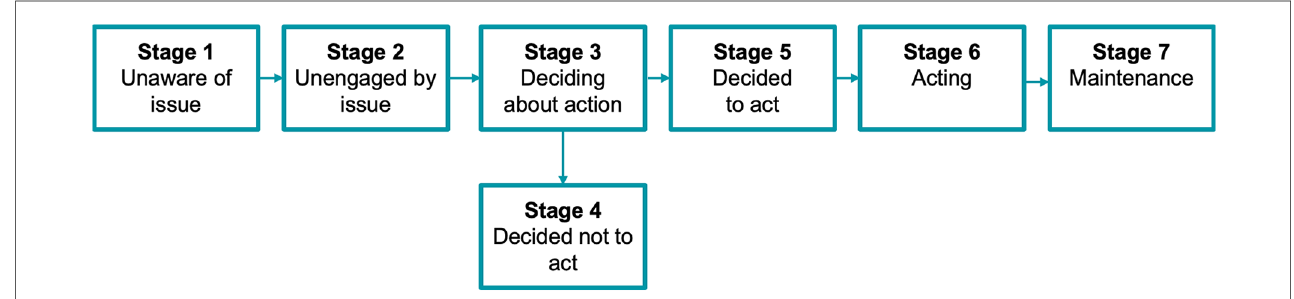
FIGURE 2 Stages of the precaution adoption process model (adapted from Weinstein and Sandman,